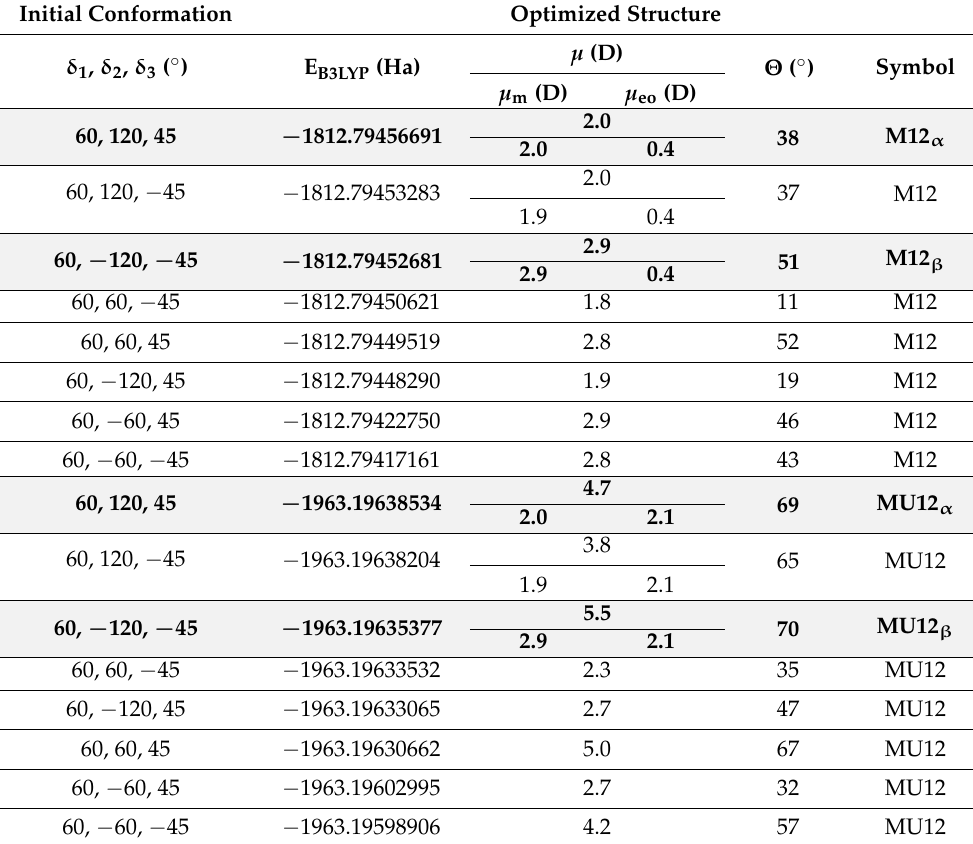
Table 3. Results of geometry optimization for M12 and MU12. The angles δ i describe the initial conformation. E is the B3LYP energy after optimization. Values of the dipole moment: µ —total, µ m —mesogen, µ eo —epoxy chain. Θ is the angle between the total dipole moment and the principal molecular axis. The chosen conformations for each molecule are